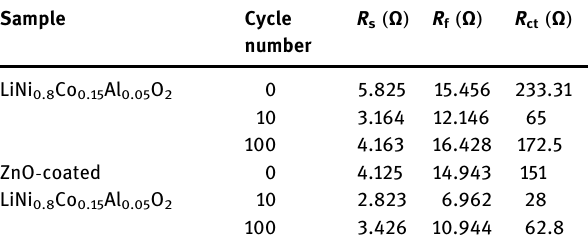
Table 3: EIS parameters of pristine and ZnO - coated LiNi 0.8 Co 0.15 Al 0.05 O 2 after di ff erent cycles Sample